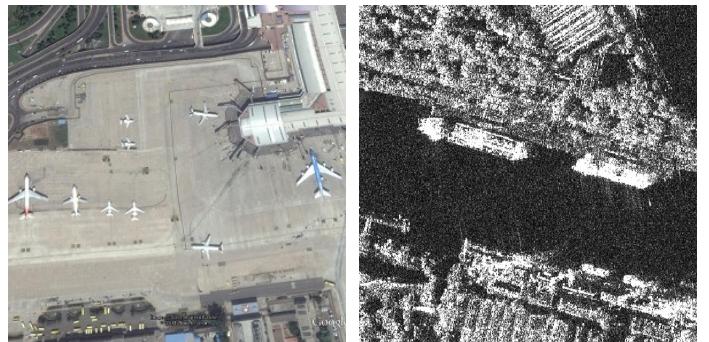
Figure 5. Typical remote sensing images. ( Left ): Optical remote sensing image with airport objects; ( Right ): SAR image with ship